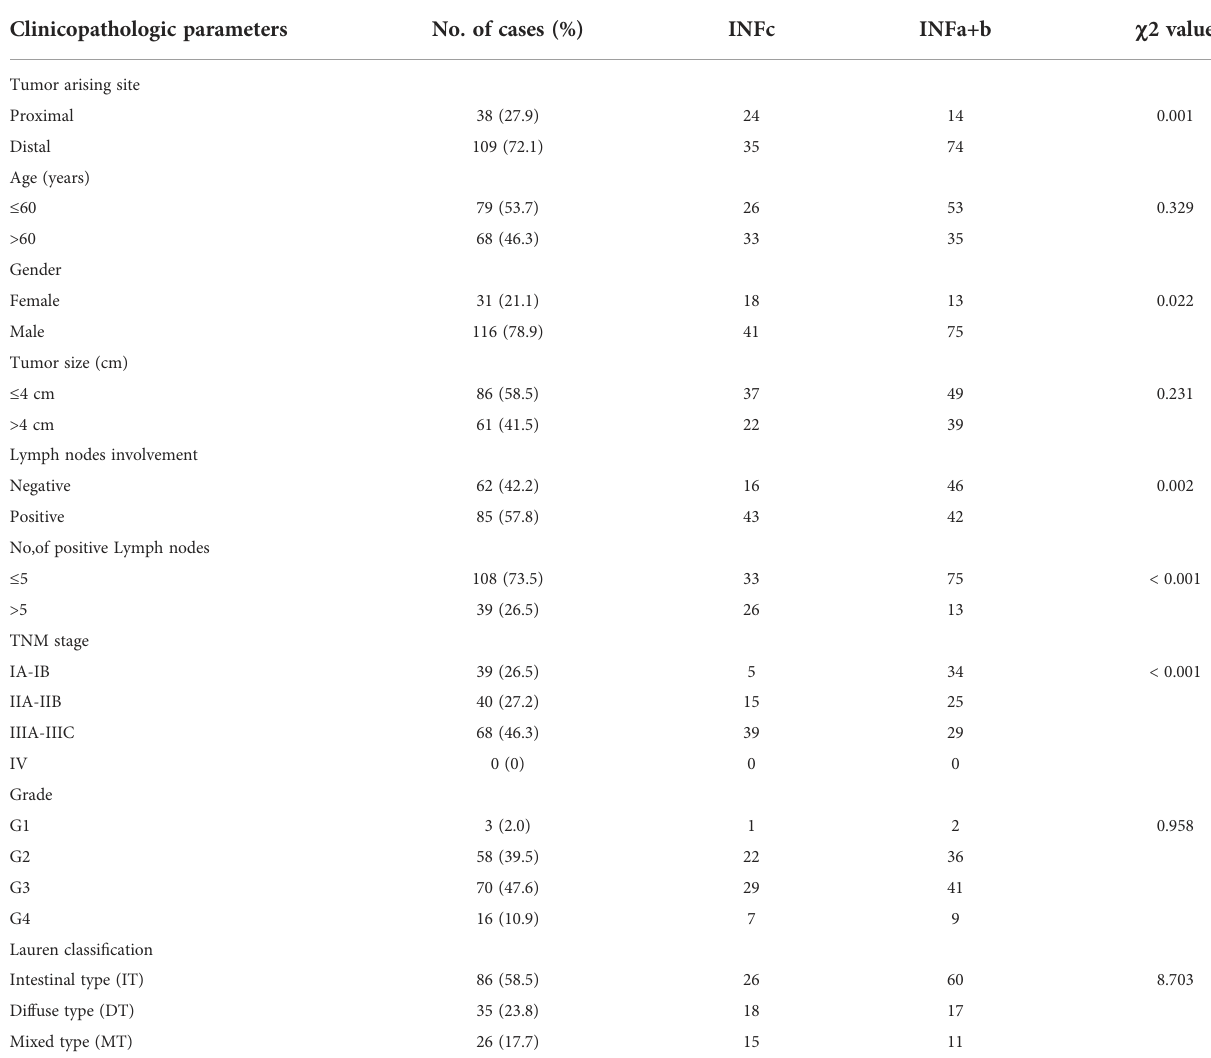
TABLE 1 Association of INF with clinicopathologic parameters. Clinicopathologic